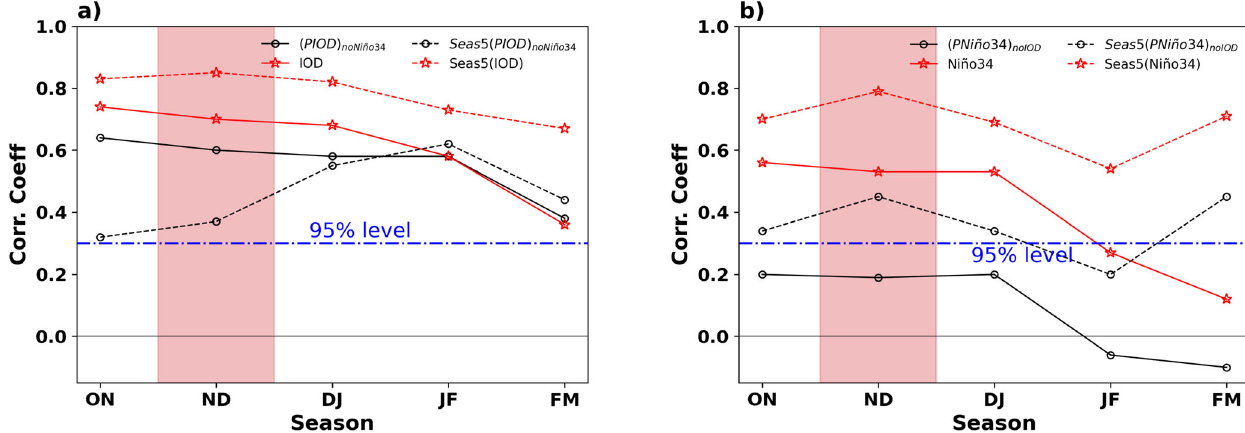
Fig. 3 Role of constructive interference of IOD and ENSO in WCIO precipitation anomalies. a Observed October IOD index (based on SST) lag Correlation Coef fi cient (CC) with the western-central Indian Ocean (WCIO) precipitation anomalies in 2-months overlapping season for the period 1981 – 2019 (red solid line with star). Same but with linearly independent October-IOD (PIOD) noNiño34 are shown in black solid line (with circle); Corresponding lines for ECMWF-SEAS5 are shown in dashed lines; ( b ) Same as panel ( a ), except using ND (November-December) Niño3.4 SST index (red solid and dashed lines) and linearly independent ND-Niño34 (PNiño34) noIOD (black solid and dashed lines). Blue line indicates the statistical signi fi cance of the CC at 95% con fi dence level.